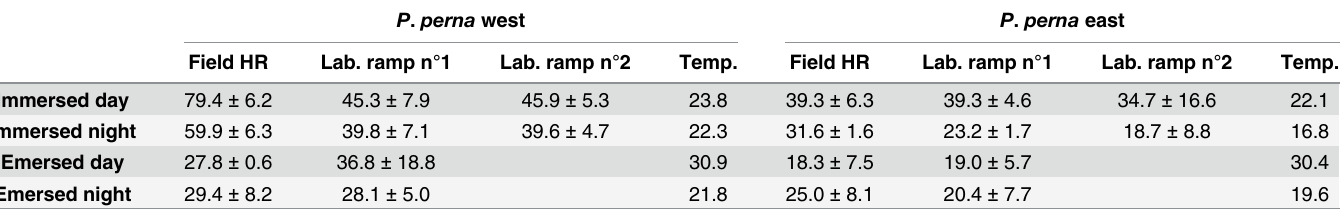
Table 1. Comparison of heart rate (HR) measured in the field and HR extrapolated from the Arrhenius plot calculated from data collected in the lab- oratory. Values are means ± standard deviation. P . perna west P . perna east Field